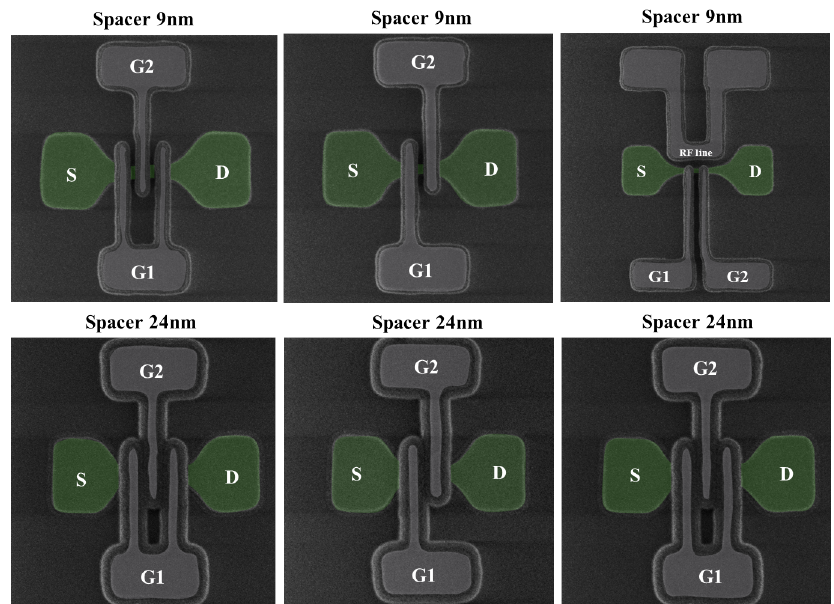
Figure 4. Examples of samples after spacer patterning. Multi-gate devices are realized with a 65nm gate pitch. Active (resp. gate) area is represented in green (grey) color. Top : a thin spacer (9nm) is used in order to create a silicide area between the two gates; Bottom : a thick spacer (24 nm) is used in order to avoid salicidation between the two gates.